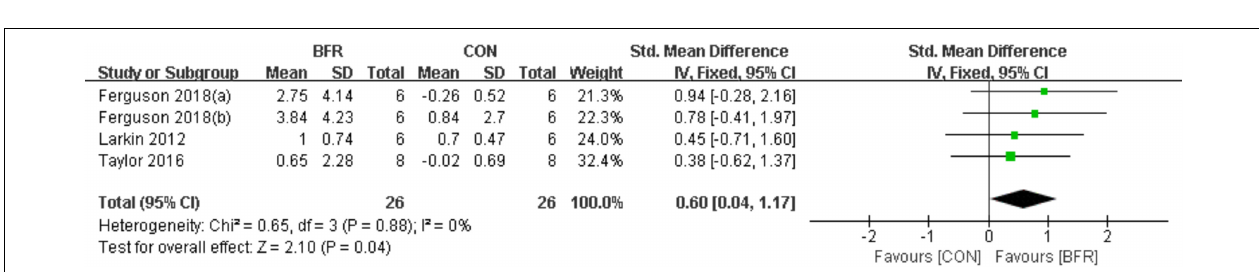
FIGURE 4 | The forest plot of the effect size for studies assessing the effect of blood flow restriction exercise on the PGC-1 α .